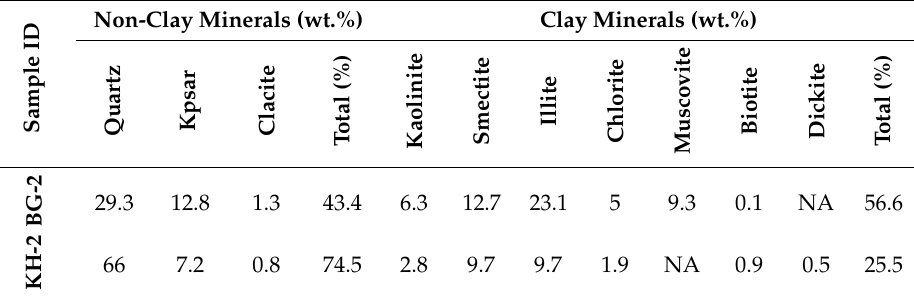
Table 3. Quantitative mineralogy of BG-2 and KH-2 shales from XRD measurement. Non-Clay Minerals (wt.%) Clay Minerals (wt.%) D I e p l m a S